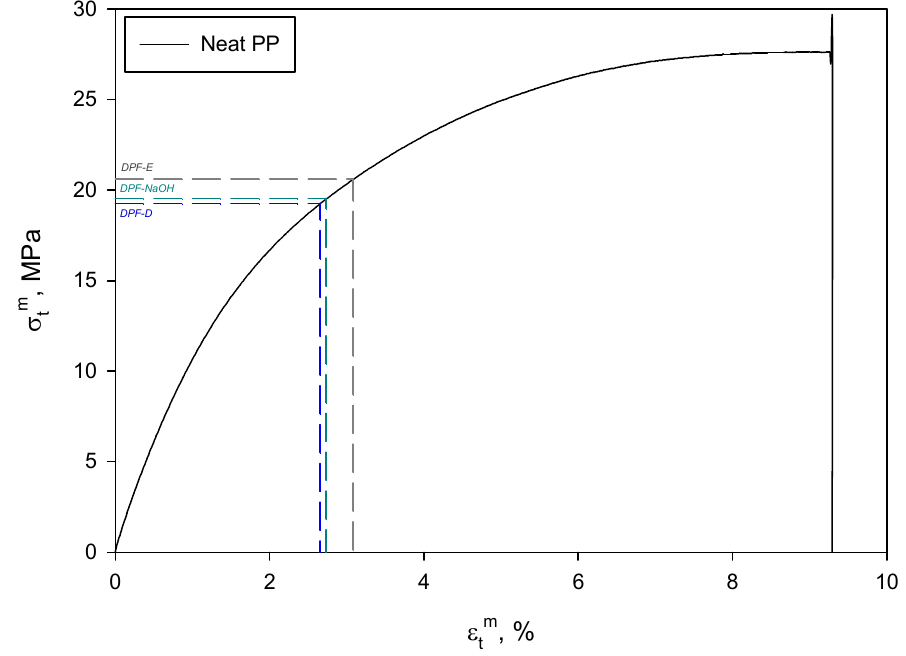
ff erent composite